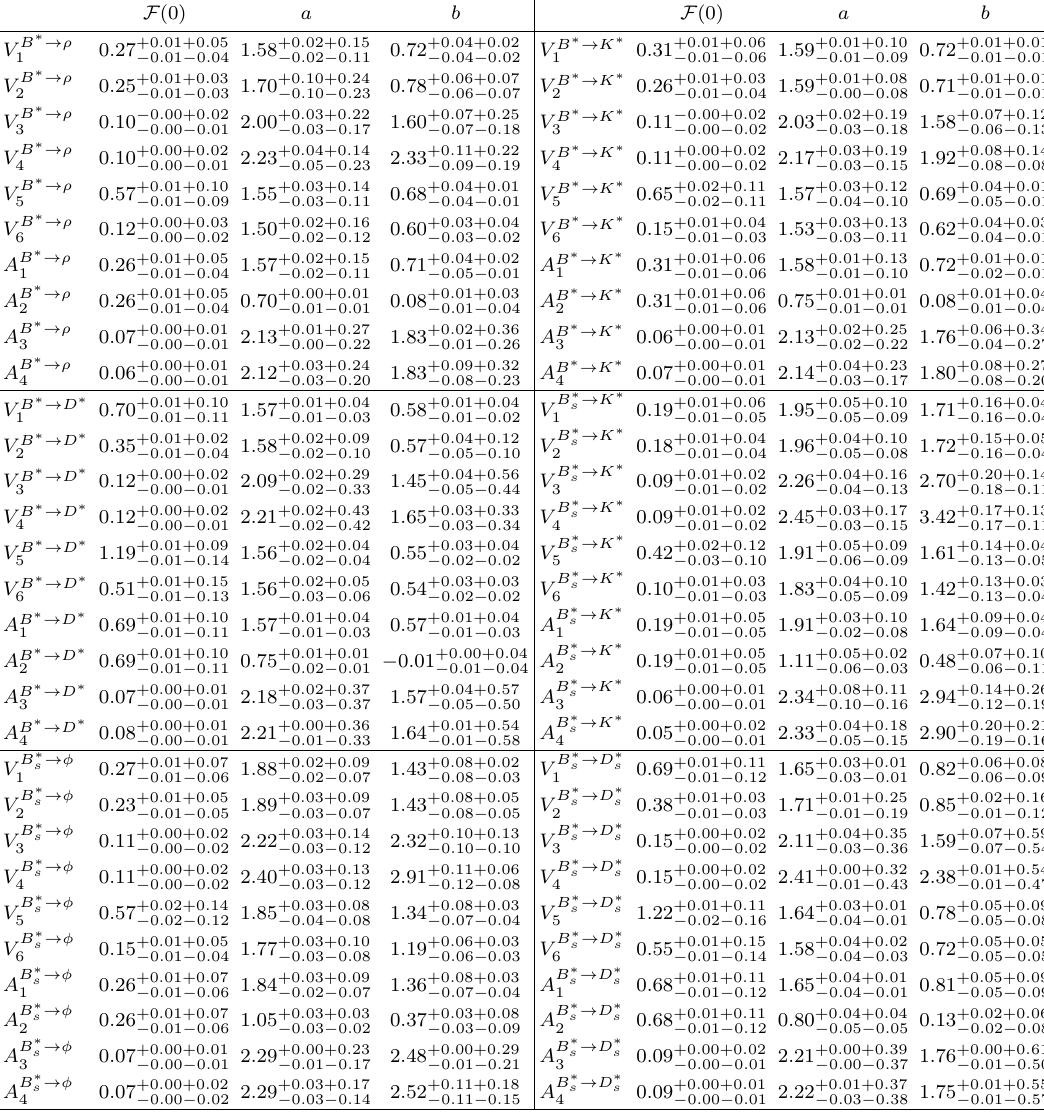
Table 9 . Same as table 5 except with the parameterization scheme given by eq. (4.15). The errors are due to parameters (cid:12) and quark masses only (cf. section 4 for a more complete